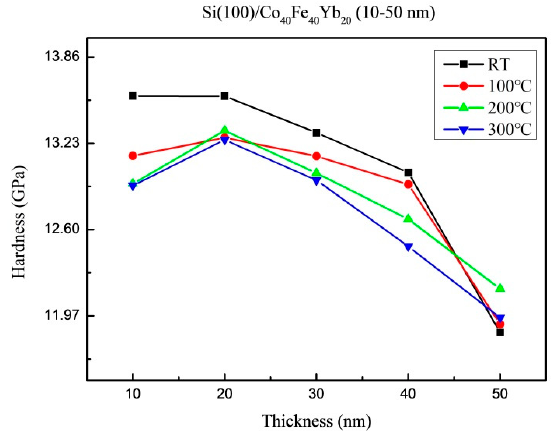
Figure 7. Average hardness of Co 40 Fe 40 Yb 20 thin films.